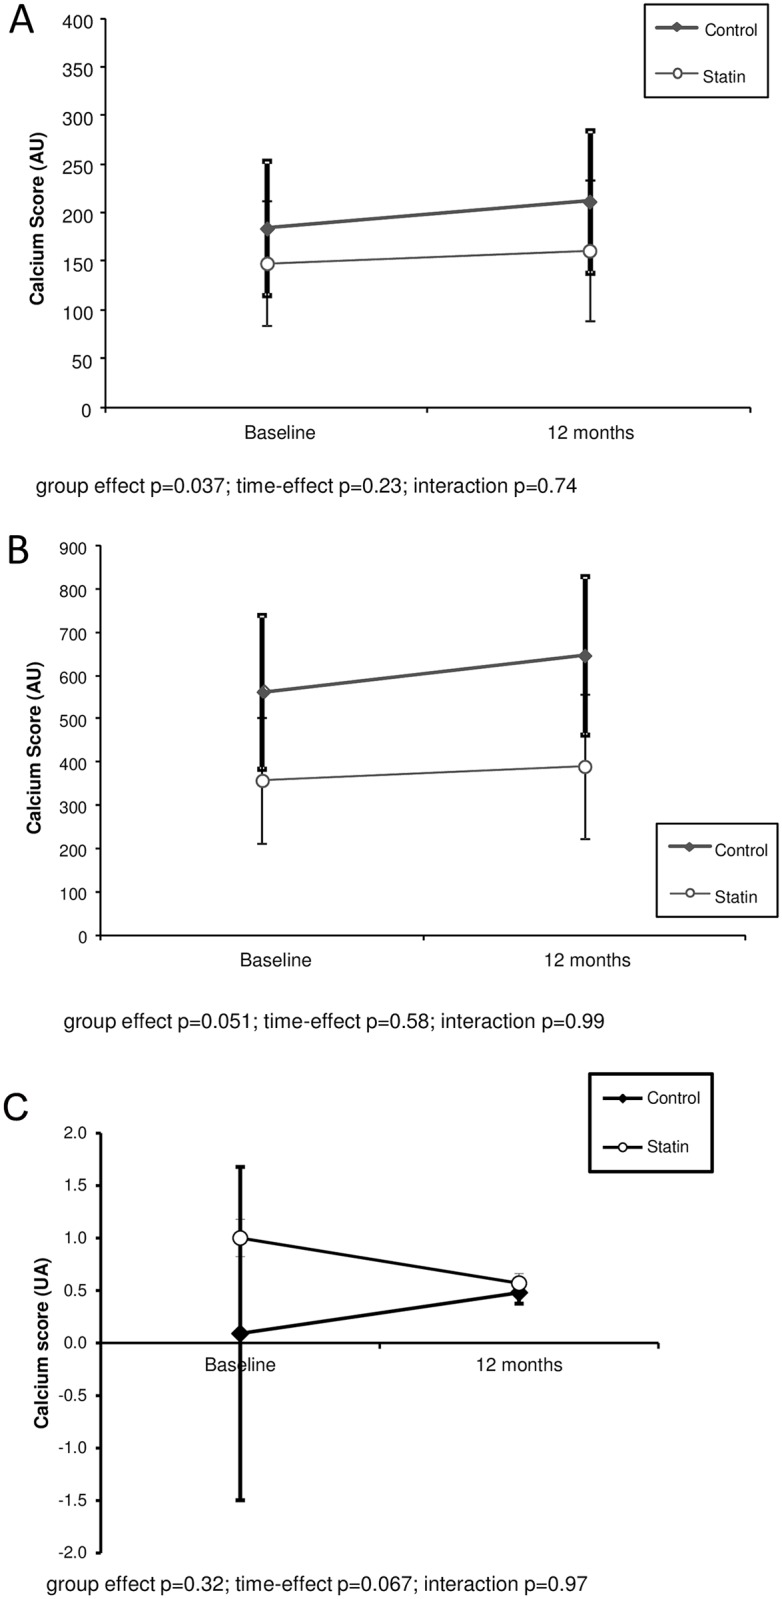
CAC progression in the groups (A—All patients; B—≥ 10 AU [calcified patients]; C—< 10 AU [non calcified patients]).